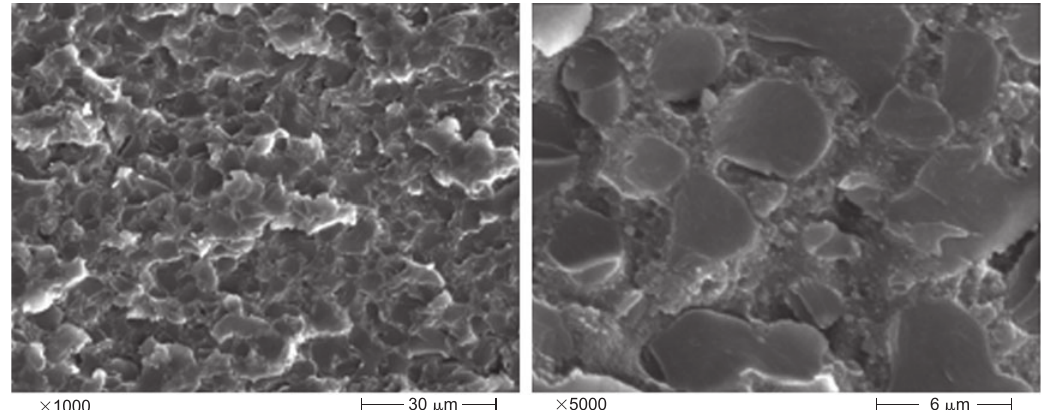
Figure 7 SEM picture from fracture surface of RTM6 ® + 10 wt %